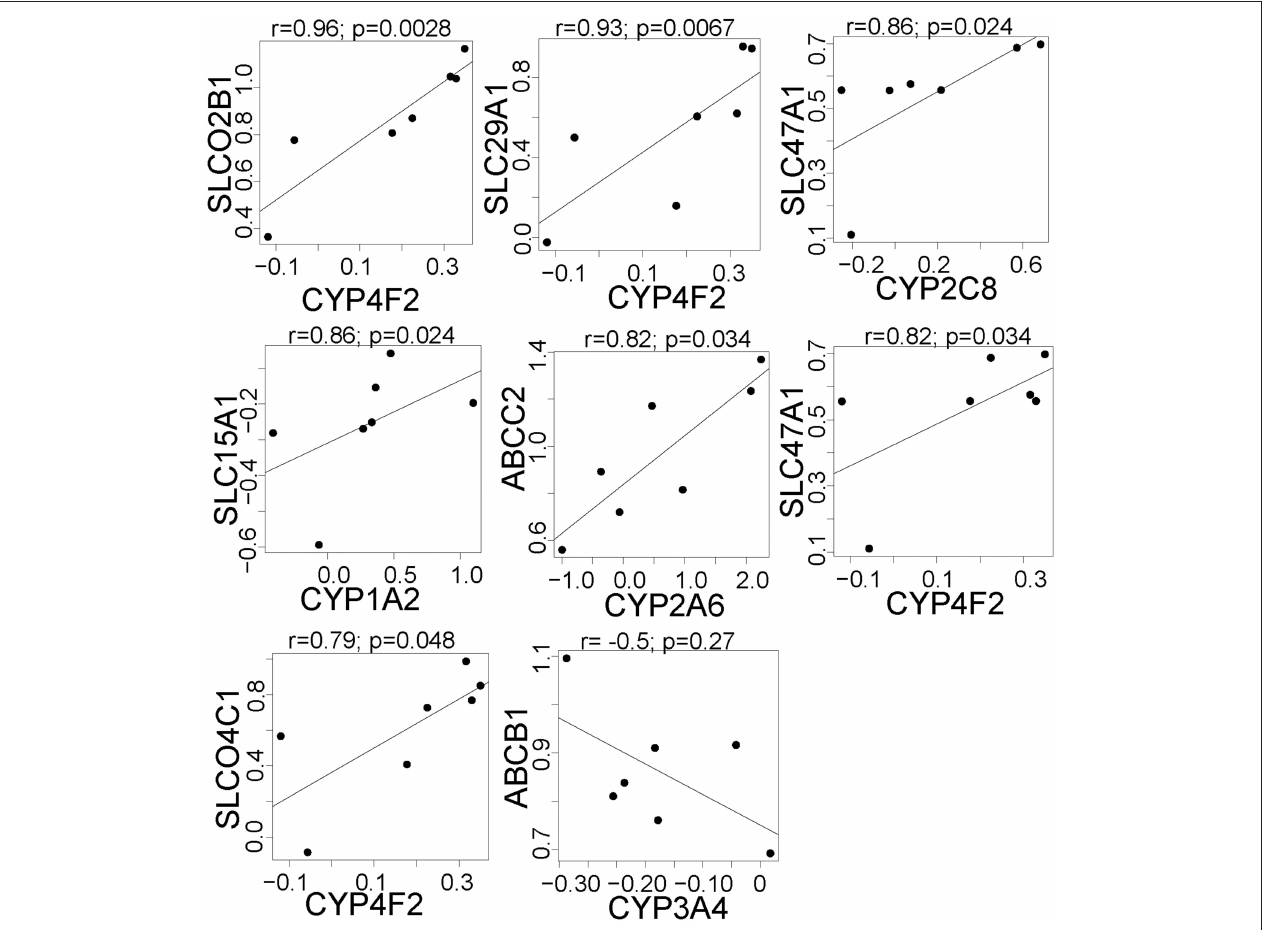
FIGURE 3 | The significant correlations between the expression of drug metabolism genes and clinically relevant transporter genes that are regulated by rifampin. The expression [represented by log2fold change (Log2FC)] after rifampin treatment was correlated between all CYP and 410 transporters genes. The figure illustrates, the seven significant positive and one significant negative correlations between the expression of CYP and drug transporter genes that were regulated by rifampin with an FDR < 0.05. These were the only correlations with a p < 0.05 by Spearman correlation. Spearman correlation was performed because an assumption of normal distribution could not be